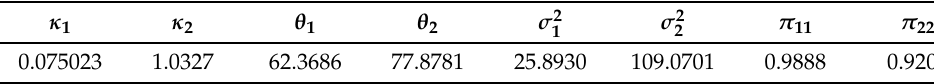
Table 8. Estimation Result of RSOU model on energy-switching data.